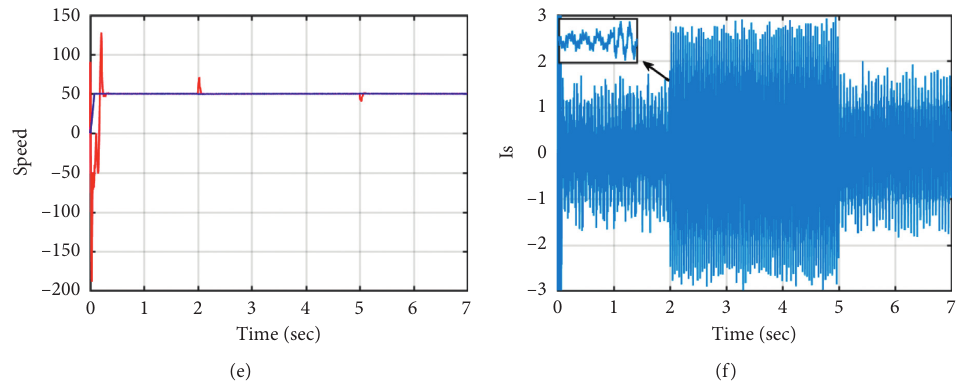
Figure 2: EKF modeling of the six-phase induction motor in 50rad/sec.